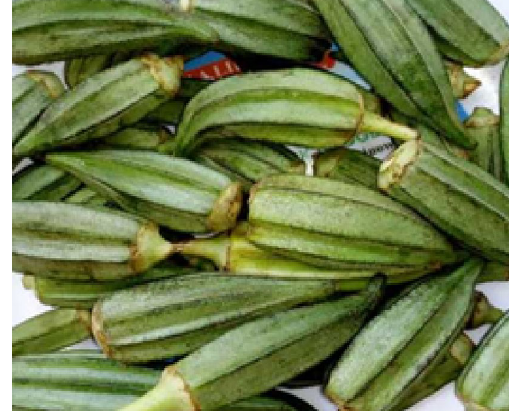
Fig. 3 Grounded sample of Irvingia